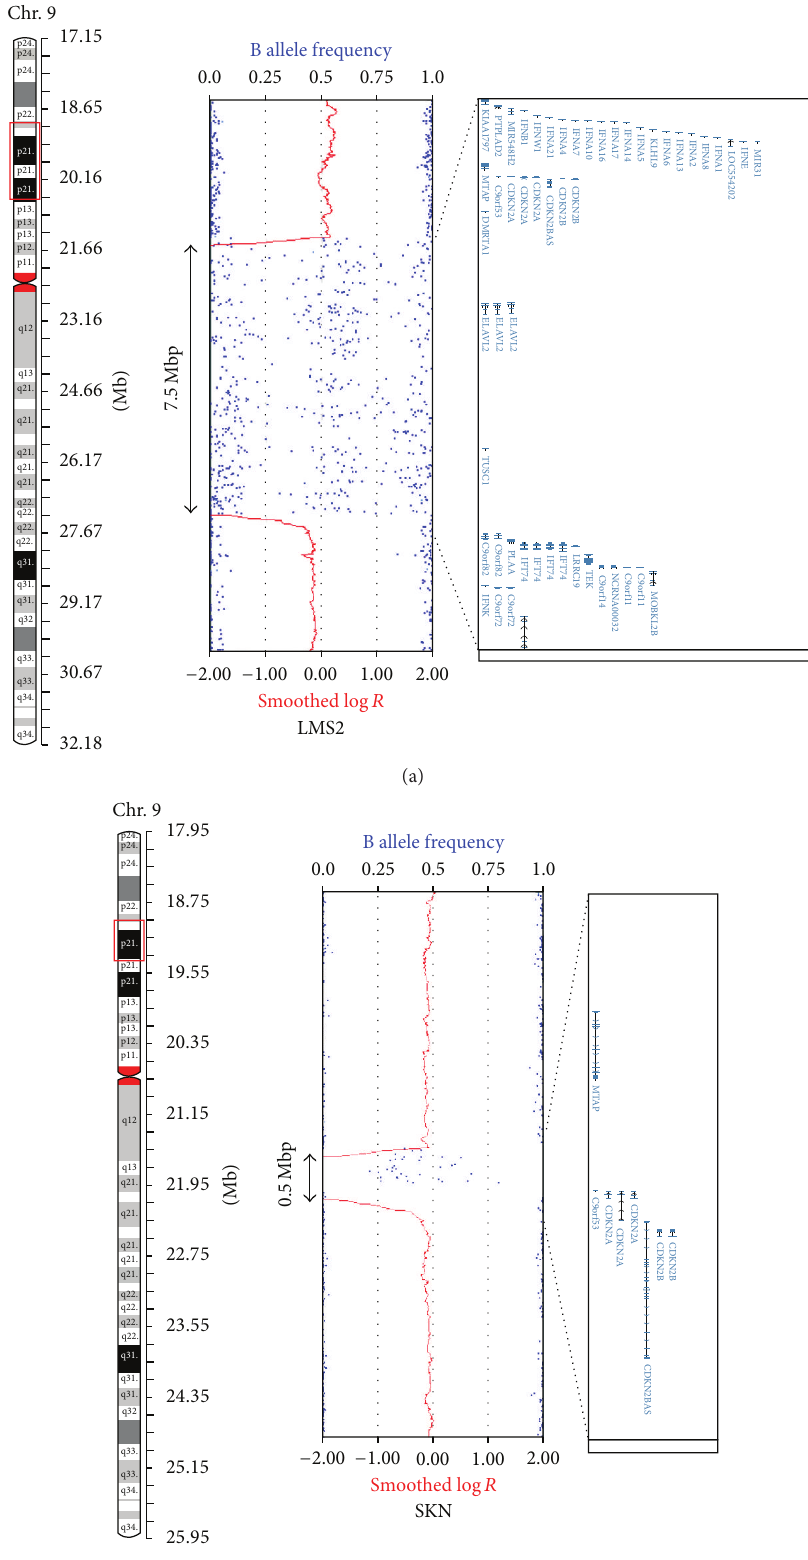
Figure 2: Homozygous deletions involving the CDKN2A and CDKN2B genes at chromosome 9p21.3 detected in LMS2 and SKN. A 7.5Mb region (Chr9: 20,908,374–28,420,020, hg19) and a 0.5 Mb region (Chr9: 21,695,893-22,195,820, hg19) were found to be homozygously deleted in LMS2 (a) and in SKN (b),